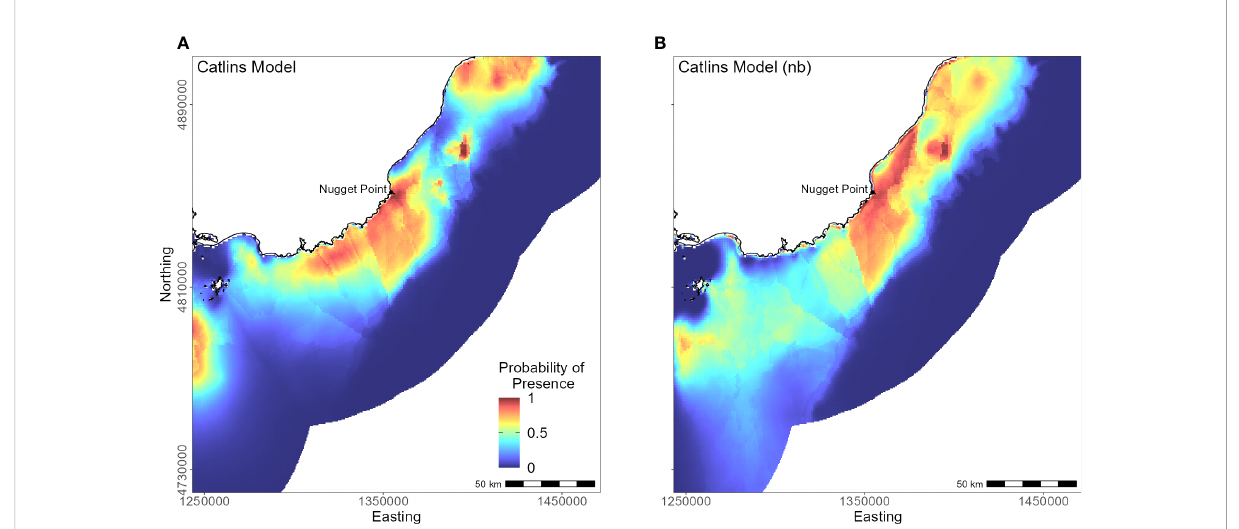
FIGURE 9 Distribution of suitable habitat for yellow-eyed penguins breeding in the Catlins. The left map (A) depicts the predicted probability of presence (cloglog) with distance to nearest colony included a predictor variable, while the right map (B) does not include distance to colony as a predictor (nb